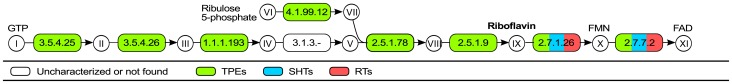
Biosynthesis of riboflavin and FAD.
Metabolites - I: Guanosine 5'-triphosphate; II: 2,5-Diamino-6-(5-phospho-D-ribosylamino)pyrimidin-4(3H)-one; III: 5-Amino-6-(5'-phosphoribosylamino)uracil; IV: 5-Amino-6-(5'-phospho-D-ribitylamino)uracil; V: 5-Amino-6-(1-D-ribitylamino)uracil; VI: D-Ribulose 5-phosphate; VII: 2-Hydroxy-3-oxobutyl phosphate; VIII: 6,7-Dimethyl-8-(D-ribityl)lumazine; IX: Riboflavin; X: Flavin mononucleotide; XI: Flavin adenine dinucleotide Enzymes - 3.5.4.25: GTP cyclohydrolase II; 3.5.4.26: diaminohydroxyphosphoribosylaminopyrimidine deaminase; 1.1.1.193: 5-amino-6-(5-phosphoribosylamino)uracil reductase; 3.1.3.-: Phosphoric monoester hydrolases; 4.1.99.12: 3,4-dihydroxy 2-butanone 4-phosphate synthase; 2.5.1.78: 6,7-dimethyl-8-ribityllumazine synthase; 2.5.1.9: riboflavin synthase; 2.7.1.26: riboflavin kinase; 2.7.7.2: FAD synthetase.